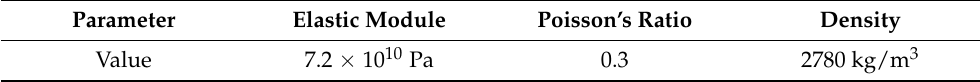
Table 1. Material parameters.